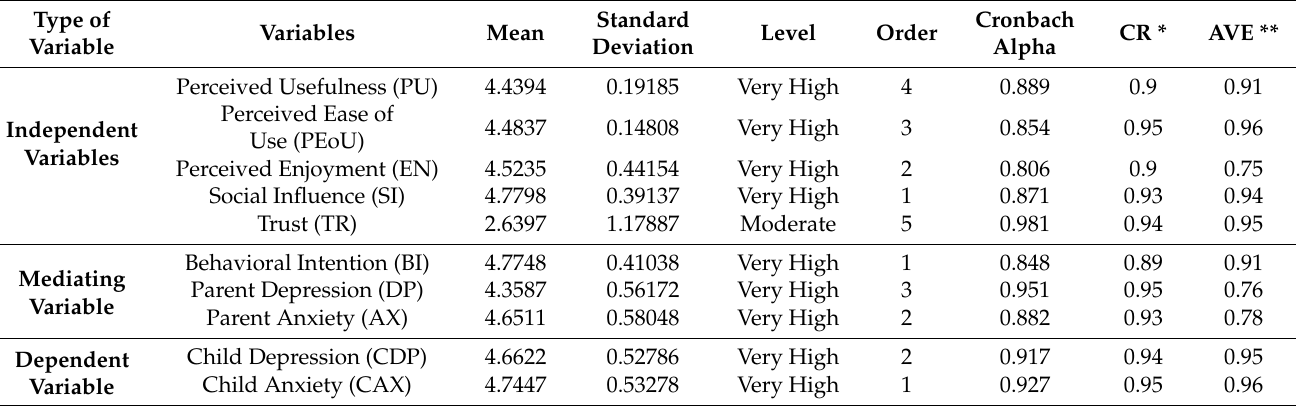
Table 3. Overall mean and standard deviation of the study’s variables.